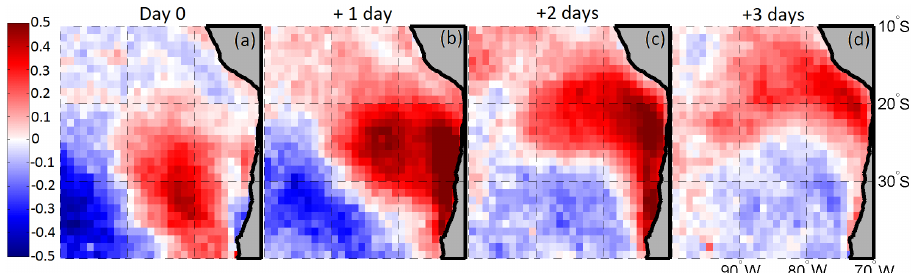
Fig. 9. (a) Fractional composite difference of N d on SLP PC2. (b) – (d) are N d composite differences on 1–3 days after strong values in SLP PC2.